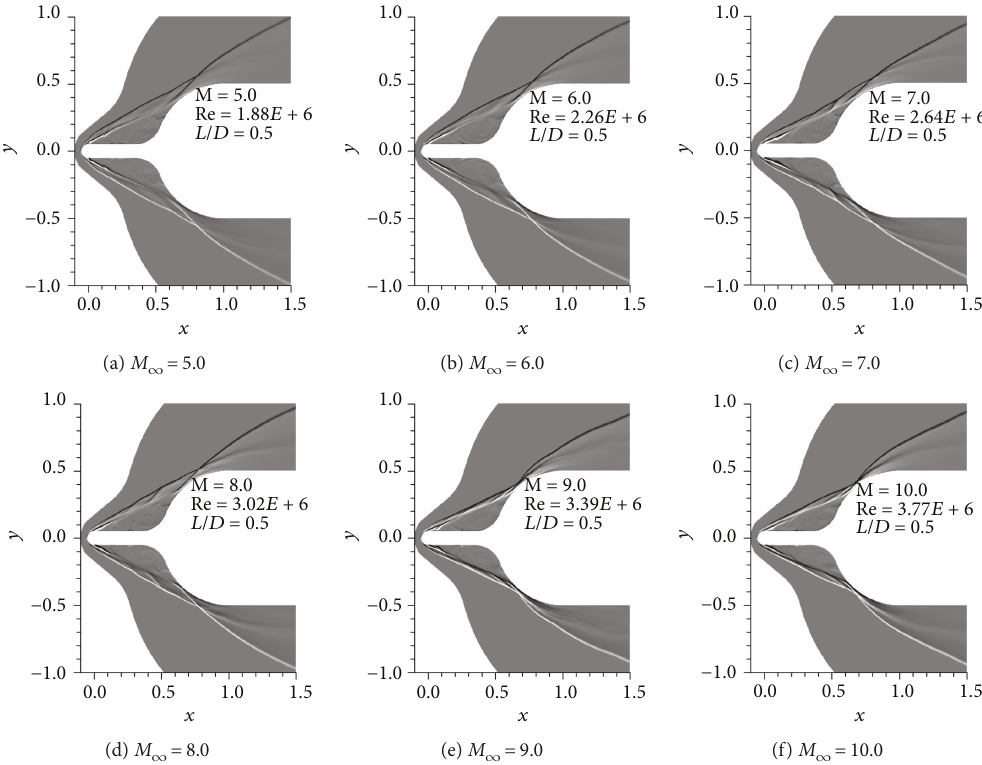
Figure 9: Flow fi eld density gradient in y direction of spiked blunt bodies with the sideward sonic jet. Spike length L/D = 0.5. L/D = 0.7 Ma = 5.0